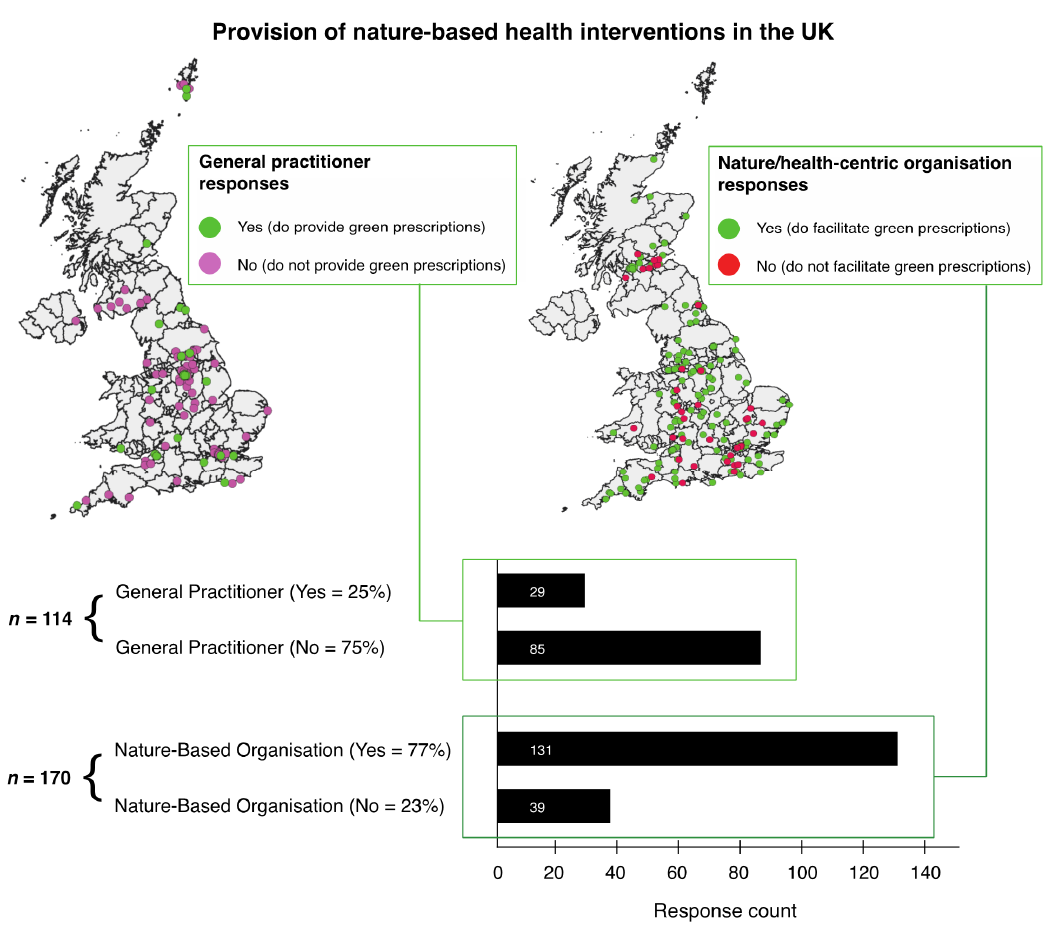
Figure 5. Provision of nature-based health interventions (green prescriptions) in the UK based on the